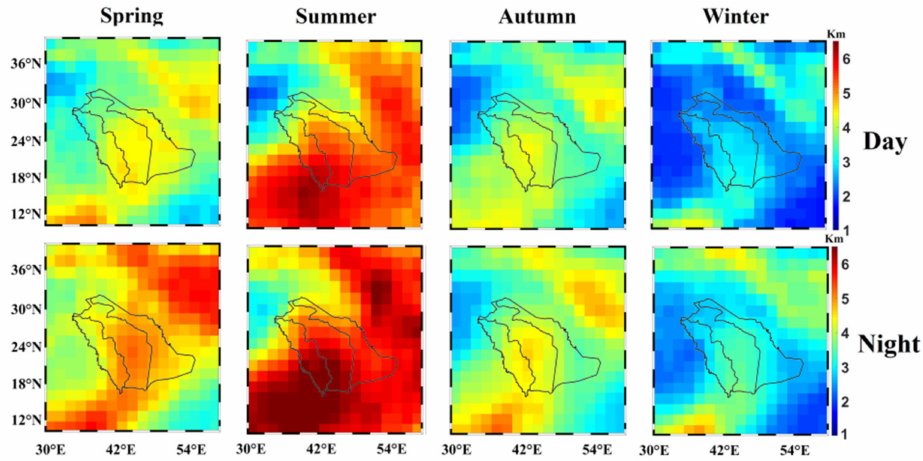
Figure 7. Seasonal spatial distributions of TAH over Saudi Arabia from 2007 to